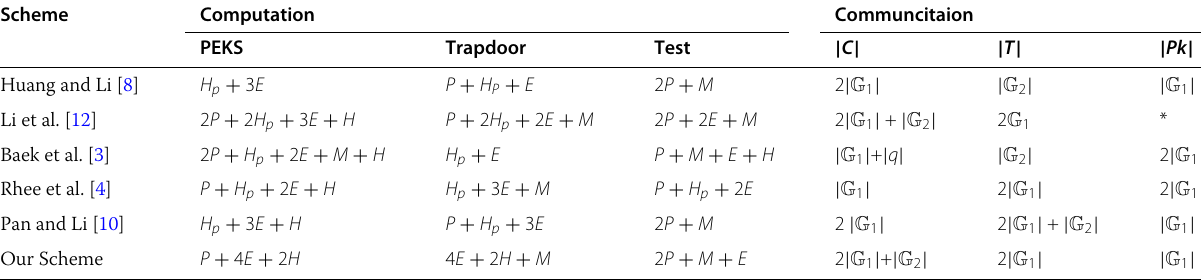
Table 3 Computation and Communcitaion efficiency comparison